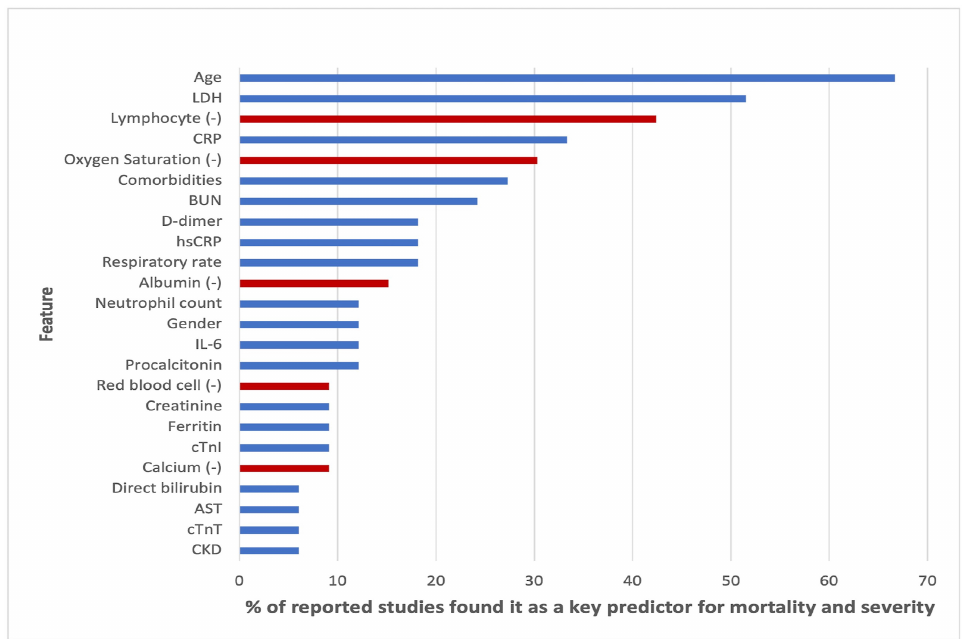
Figure 8. Top features found as most important features in prognosis of COVID-19 modified from